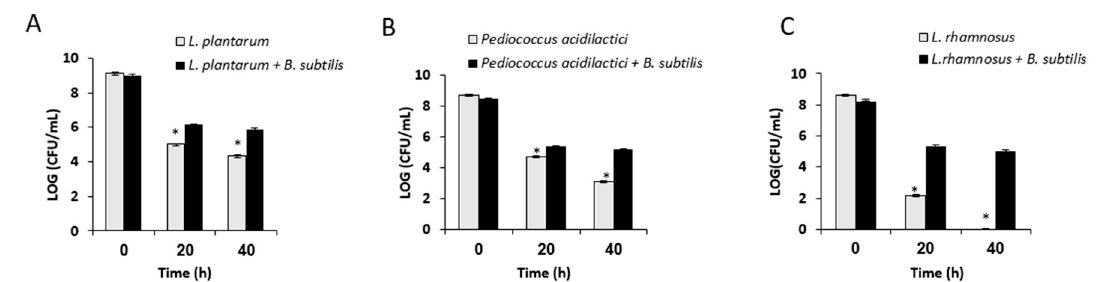
Figure 3. Growth in dual-species biofilm increases survivability of LAB during exposure to drying process. Mono and dual-species cultures of B. subtilis and LAB cells were generated in MMRS medium during bacterial growth for 8 h in 37 ◦ C, 50 rpm. Survival rates of the LAB cells (grown in presence or absence of biofilm forming B. subtilis ) were determined based on CFU counts following desiccation conditions (40% relative humidity (RH)) for 20–40 h. Error bars represent standard deviation (SD). * p < 0.05 comparison of the control and tested samples. ( A ) L. plantarum survival rates, ( B ) P. acidilactici survival rates, and ( C ) L. rhamnosus survival rates.